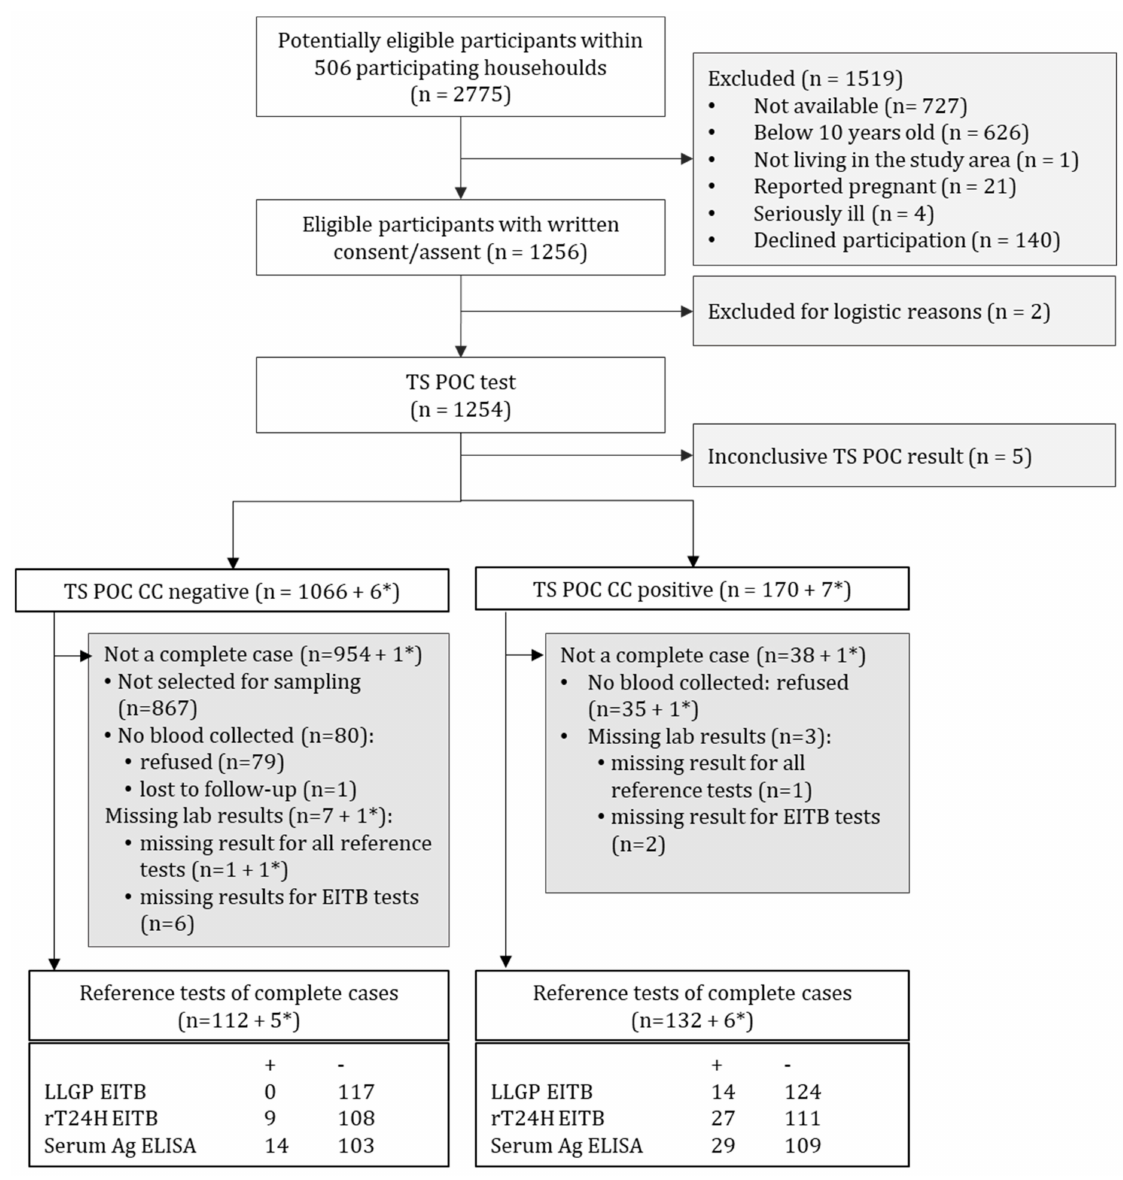
Figure 2. Flow diagram of participants to assess the diagnostic accuracy of the TS POC CC test strip (index test). (*) Number of participants who tested positive on the TS POC T test strip. In total, 13 participants tested positive using the TS POC T test strip, and all were selected to give a blood and stool sample. Table 1. Demographic characteristics of TS POC tested participants (n =